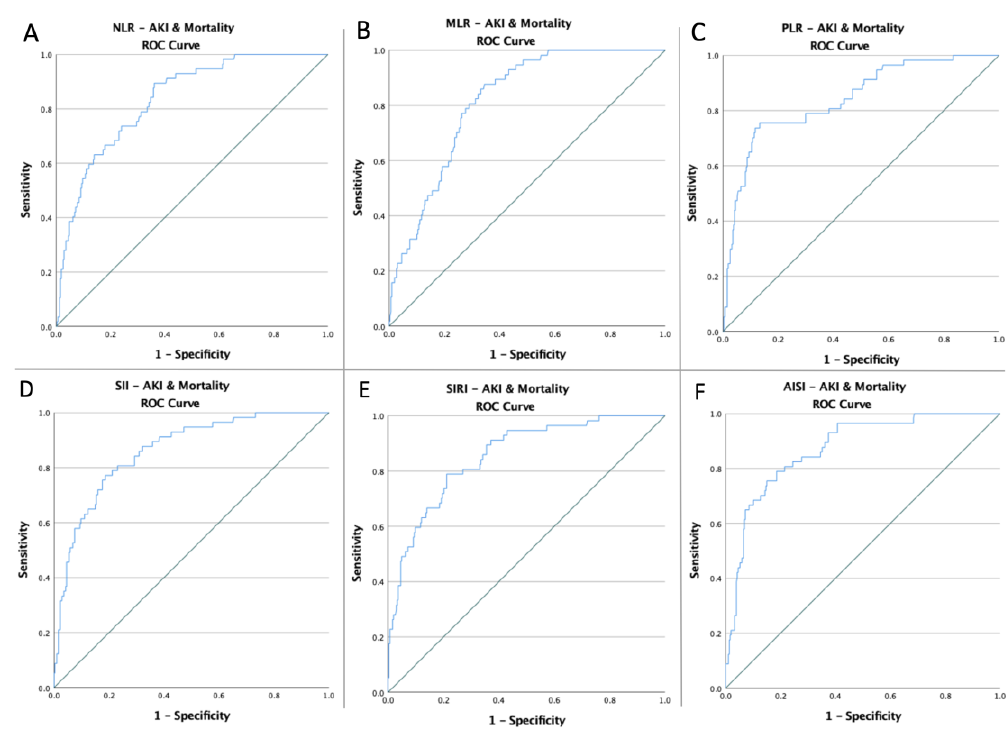
Figure 3. ROC curve analysis concerning the composite endpoint ( A ) NLR (AUC: 0.835; p < 0.0001), ( B ) MLR (AUC: 0.817; p < 0.0001), ( C ) PLR (AUC: 0.841; p < 0.0001), ( D ) SII (AUC: 0.862; p < 0.0001), ( E ) SIRI (AUC: 0.855; p < 0.0001), and ( F ) AISI (AUC: 0.873; p < 0.0001); blue line – ROC curve; green line – diagonal